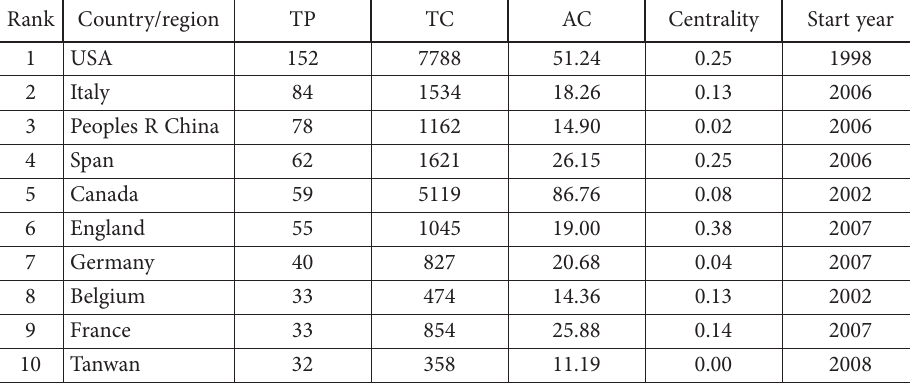
Table 3. The most productive